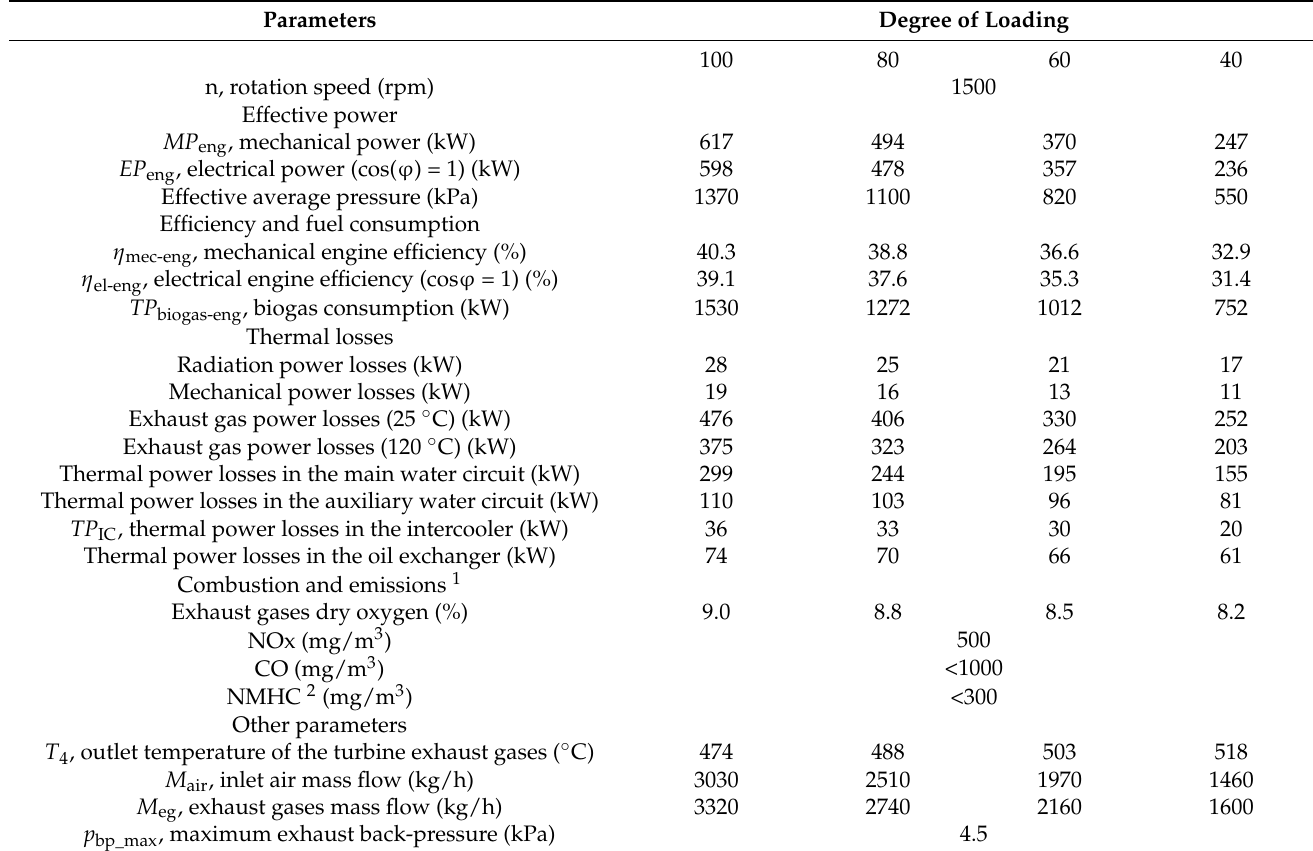
Table 3. Engine operating parameters obtained at different loading